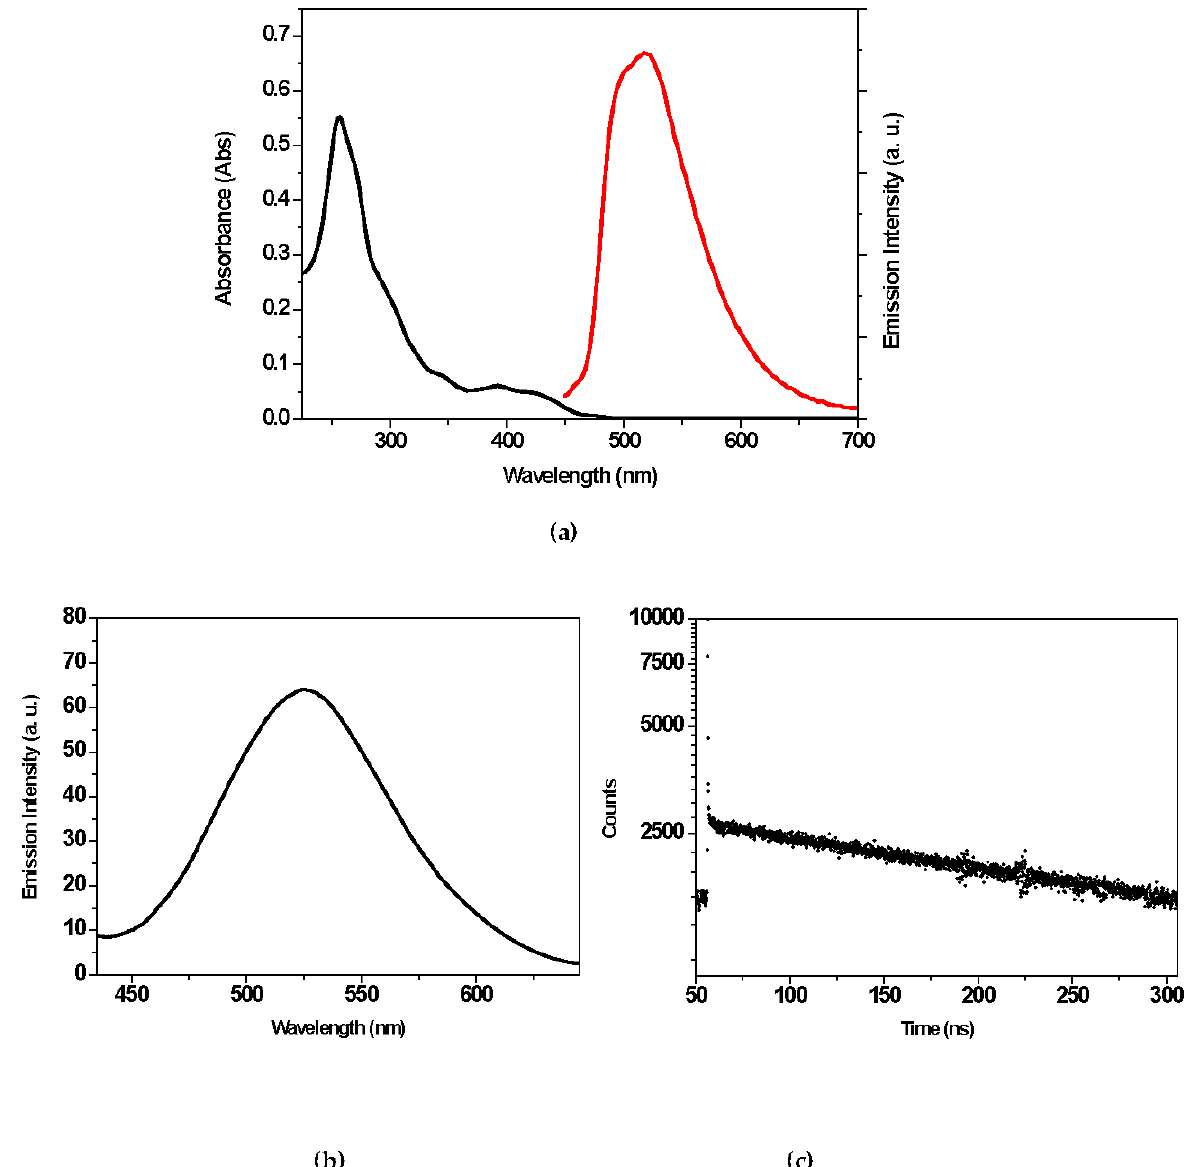
Figure 2. ( a ) Absorption and emission spectra of 1 in water solution (2 · 10 − 5 M). The emission spectrum was acquired under one-photon excitation at 400 nm. ( b ) Emission spectrum and ( c ) time-resolved fluorescence decay of 1 in water solution (1.54 · 10 − 2 M) under two-photon excitation at 800 nm. The used fitting equation was I(t) = I 0 + α 1 exp ( − t/ τ 1 ) + α 2 exp (t/ τ 2 ), with I 0 = 621.51, α 1 (%) = 32, α 2 (%) = 68, τ 1 = 0.21 ns, τ 2 = 388.4 ns and a χ 2 = 0.973.